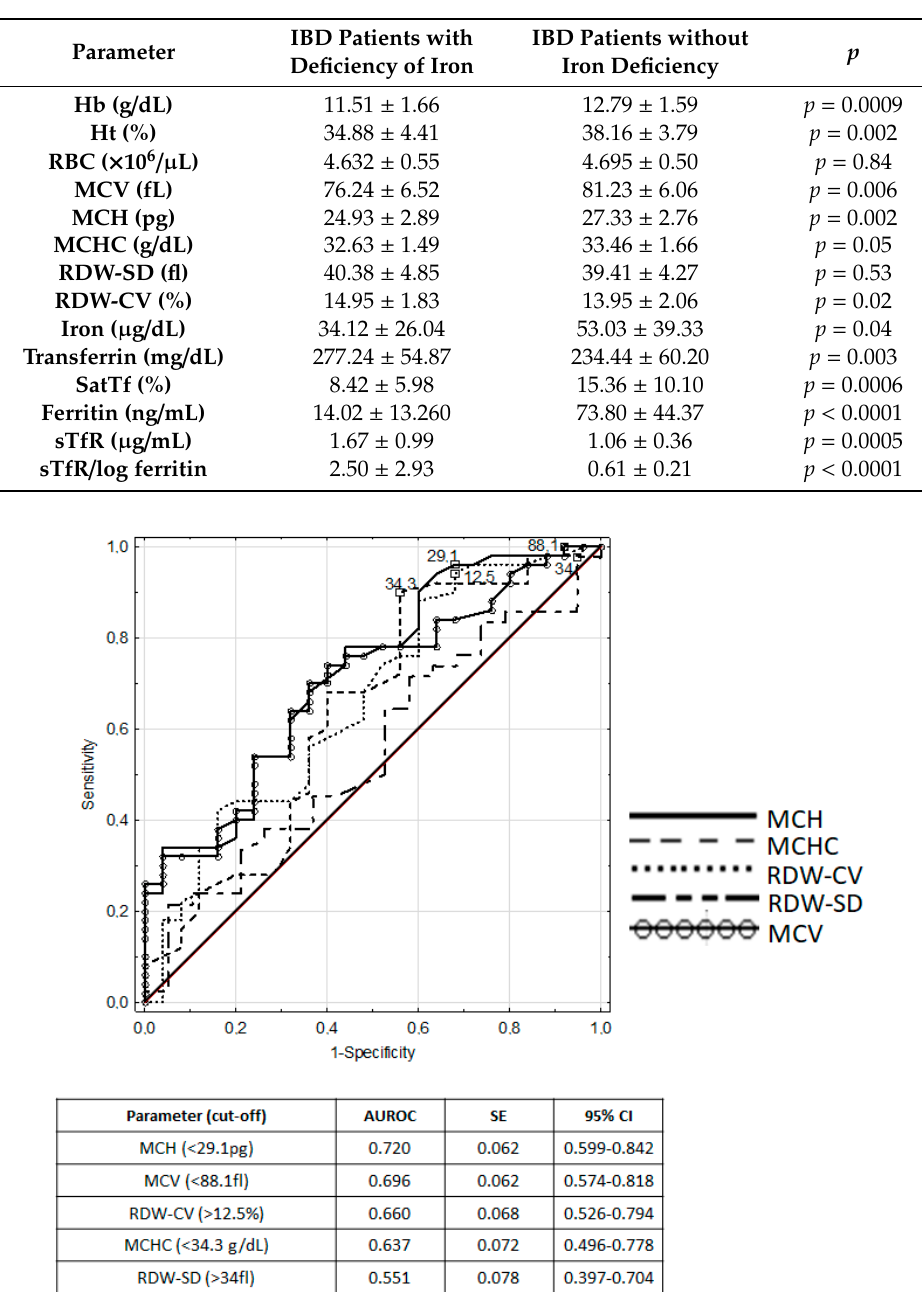
Figure 1. ROC curves and area under ROC for red blood cell indices in iron deficiency recognition in IBD children.